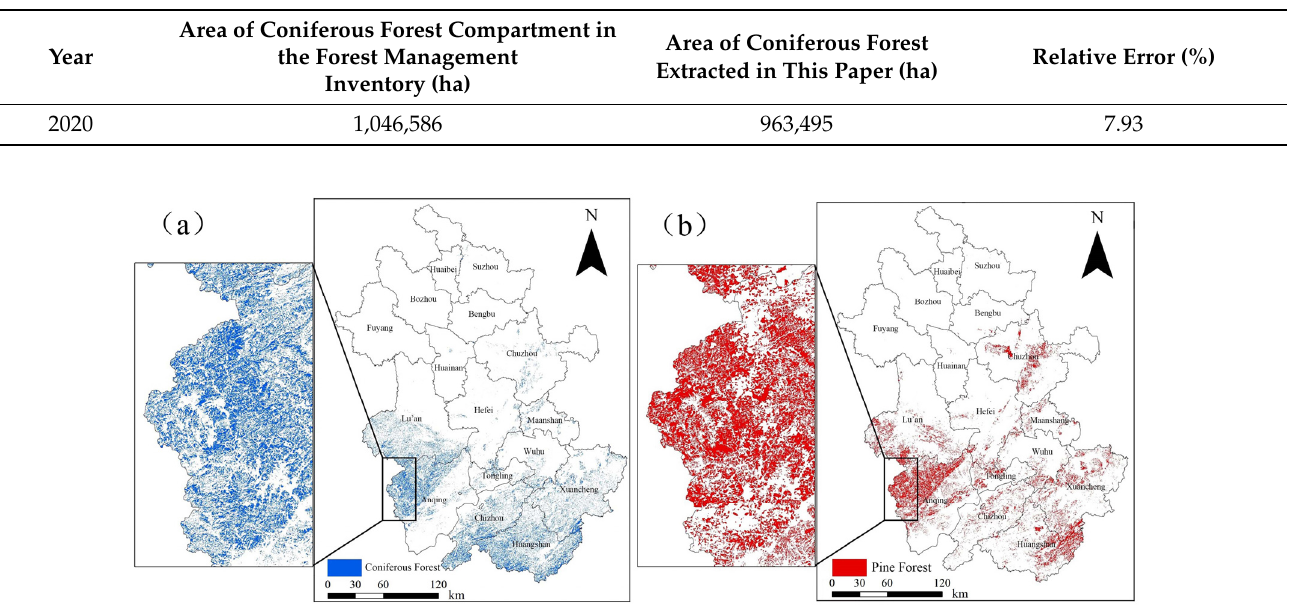
Figure 6. Comparison of the extracted coniferous forest area and the distribution area of pine forest sub-compartments. ( a ) Area of coniferous forest extracted in this paper. ( b ) Area of coniferous forest in Forest Management